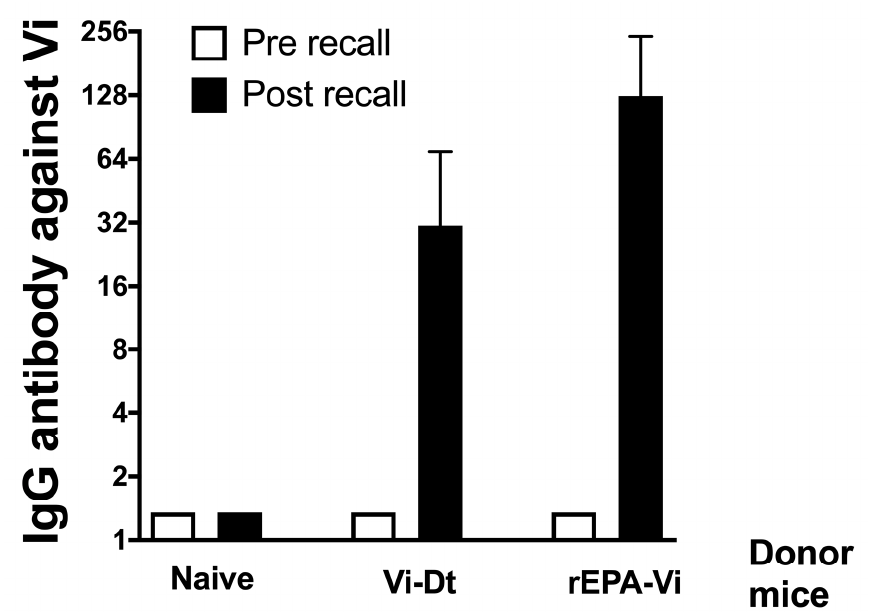
Figure 1. Recall of memory response for Vi-Dt conjugate and rEPA-Vi MAPS complex. The adoptive transfer was carried out as described in the “Materials and Methods” section. Each group contained five mice.